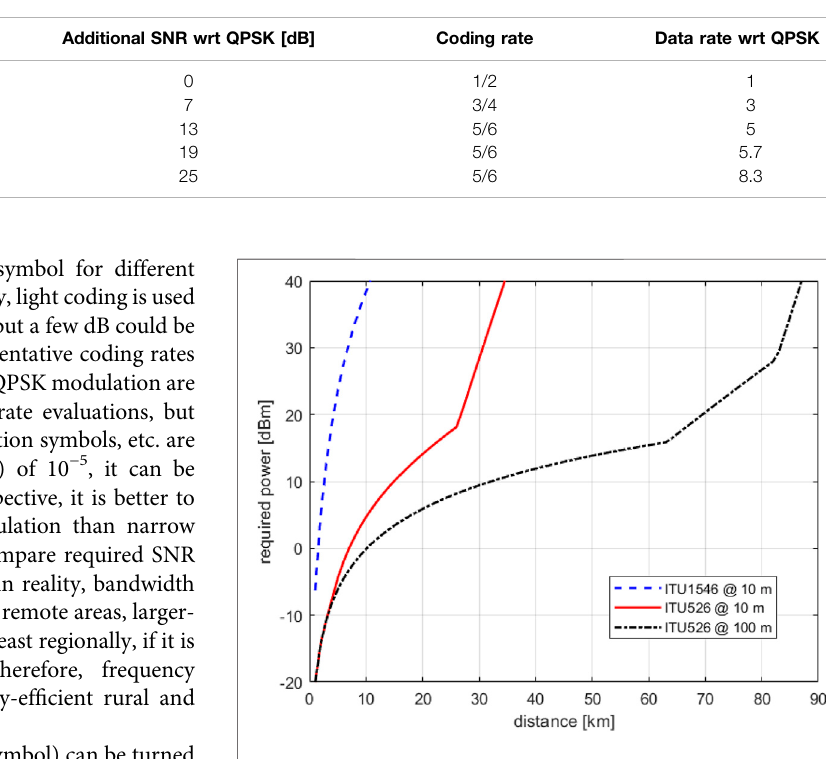
FIGURE 2 | Required PA power at 700 MHz carrier frequency as a function of link distance with 40 MHz bandwidth and QPSK modulation with 1/2-rate